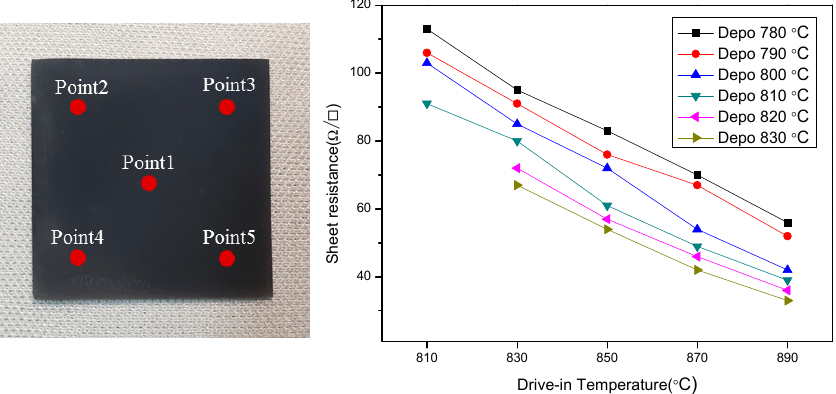
Figure 1. Surface resistance measurement point and surface resistance in the emitter layer with a temperature difference between the pre-deposition and diffusion processes.